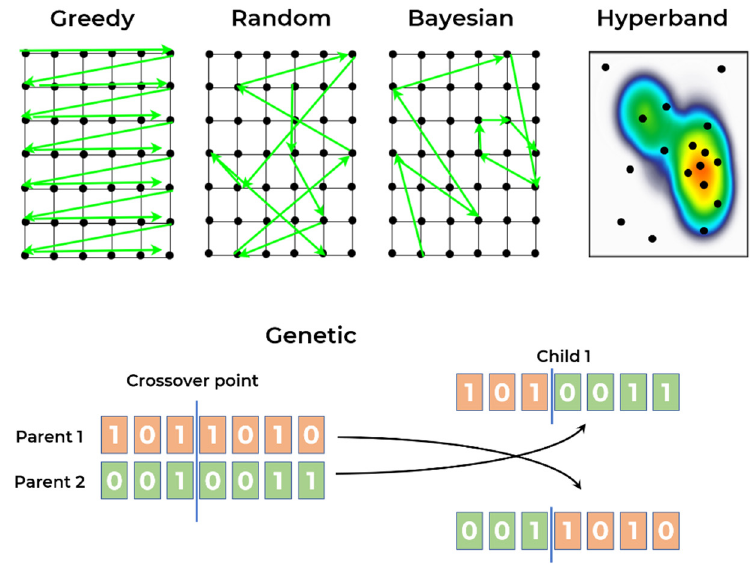
Figure 5. Illustration of the NAS strategies applied in